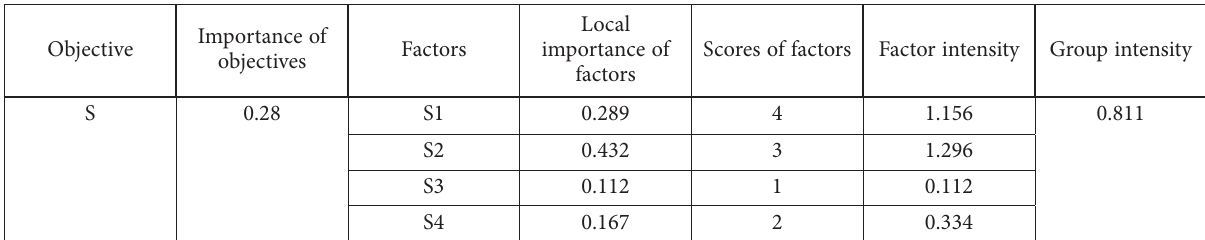
Table A2. Intensity for strength factors and groupings in SNC (one expert)